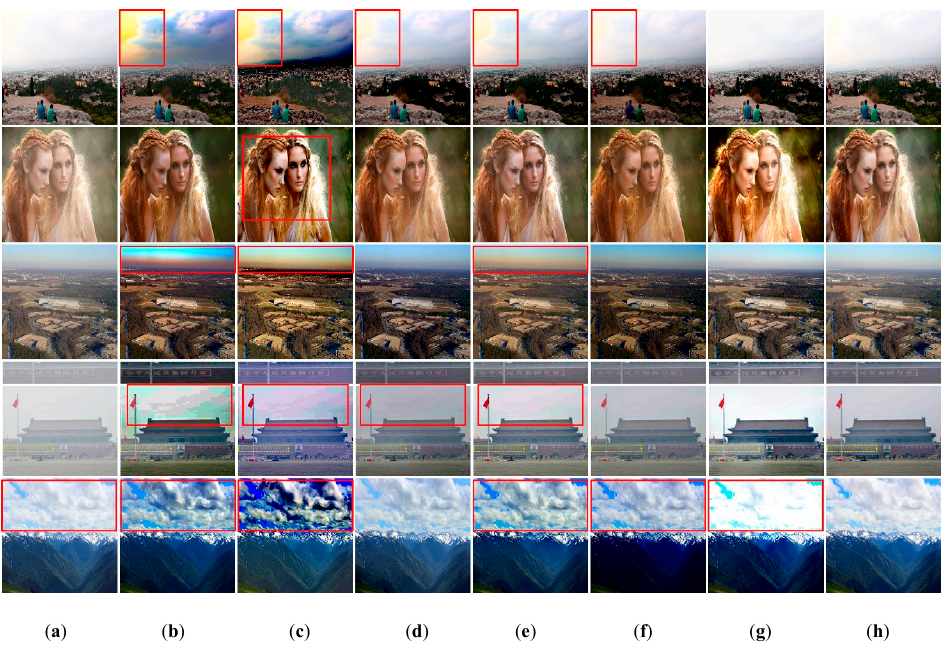
Figure 10. The results of the real-world images dehazing by ours compared to six state-of-the-art dehazing methods. ( a ) Input hazy images, ( b ) He et al. [7], ( c ) Berman et al. [32], ( d ) Cai et al. [9], ( e ) Ren et al. [10], ( f ) Li et al. [11], ( g ) Zhang et al. [33], ( h ) ours. Where the red boxes represent color distortions or halo effects.